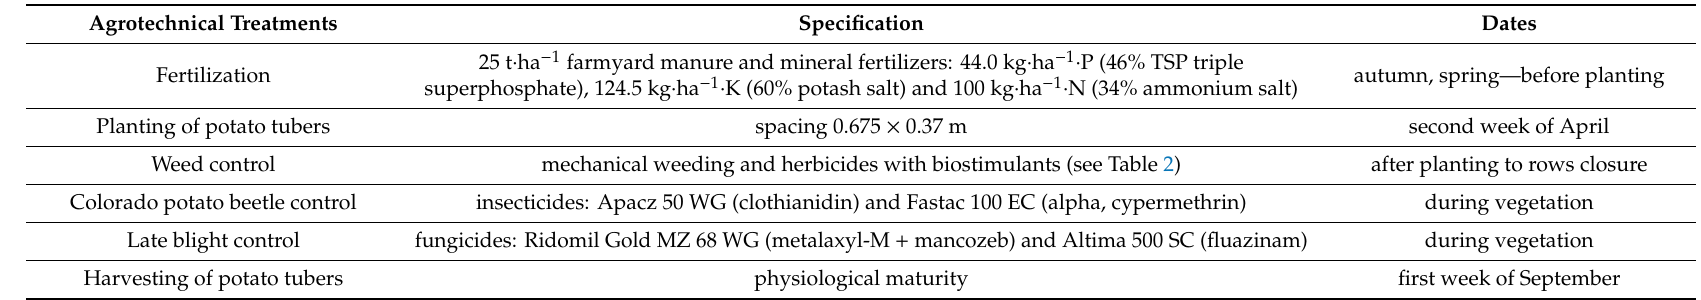
Table 3. Agrotechnical treatments used in the field